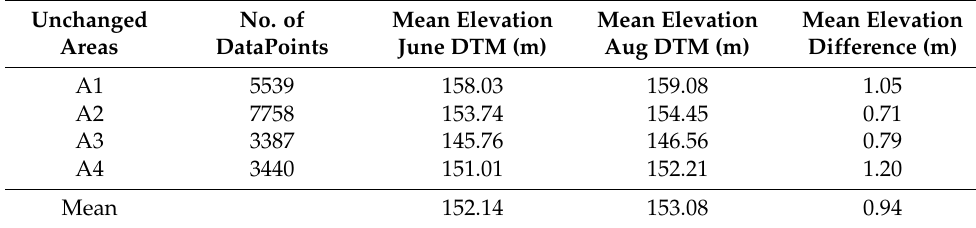
Table 6. Mean elevation and mean elevation difference for each unchanged